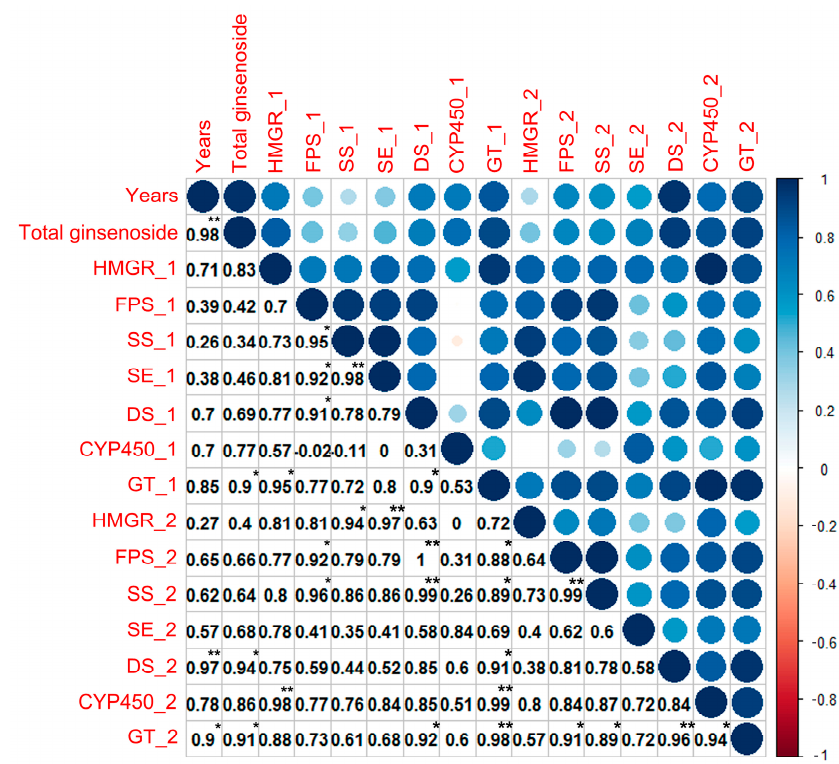
Figure 7. The correlation analysis of total ginsenoside and the individual ginsenosides. (** The correlation is significant, with a confidence level (double test) of 0.01. * The correlation is significant, with a confidence level (double test) of 0.05. Underscore 1 (_1) represents the gene expression of a key enzyme. Underscore 2 (_2) represents the activity of a key enzyme).